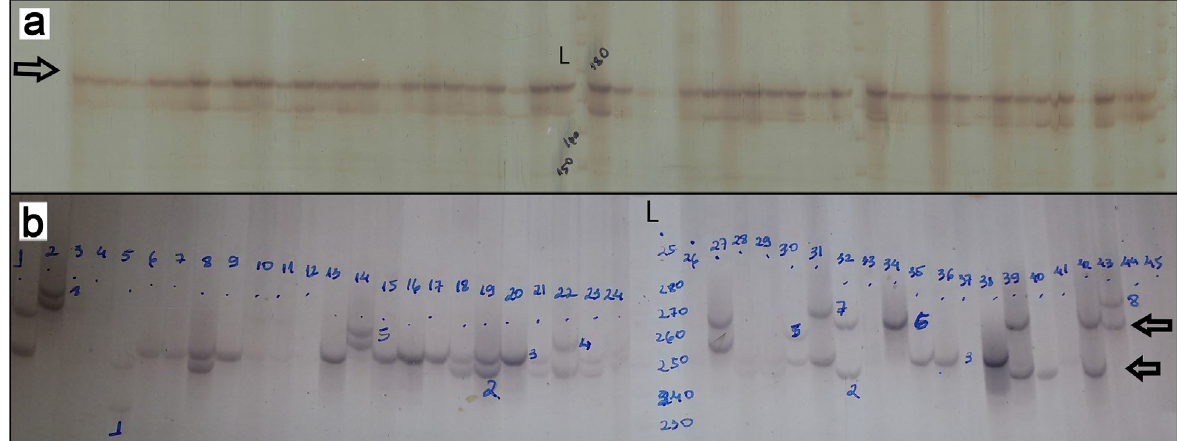
Figure 4. (a) Monomorphic profile of locus RM332 for population 2 of Guadua aff. chaparensis (L: Ladder 10 pb LifeTechnologies®). The arrow in the image indicates the presence of an allele in all individuals evaluated.). (b) Polymorphic profile of locus FJ444930 for population 3 of G. aff. chaparensis (L: Ladder 10 pb Life Technologies®). The arrows in the image indicate the presence of two alleles in individual